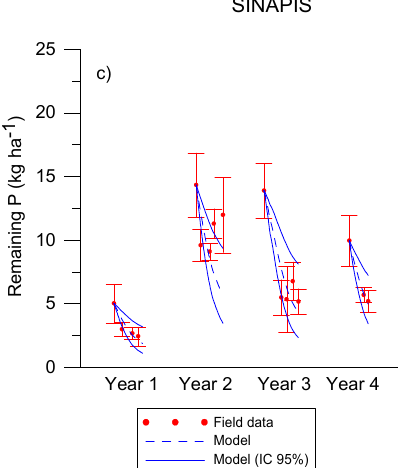
Figure 4. Measured and modelled P amounts during the four decomposition cycles for spontaneous cover ( a ), Brachypodium ( b ) and Sinapis ( c ). Table 8. Coe ffi cients for model evaluation and statistics obtained in simulations.